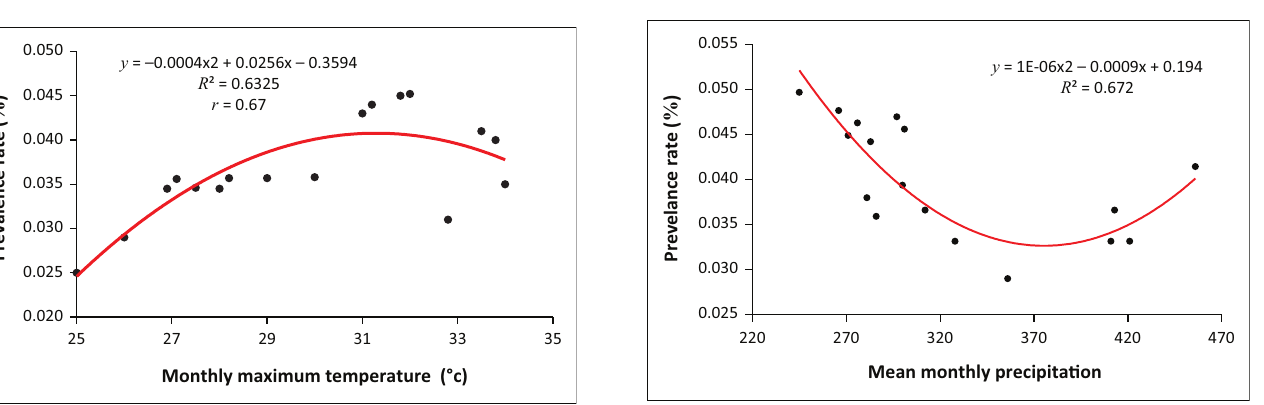
FIGURE 7: Relationship between the prevalence of malaria and mean monthly maximum temperature.